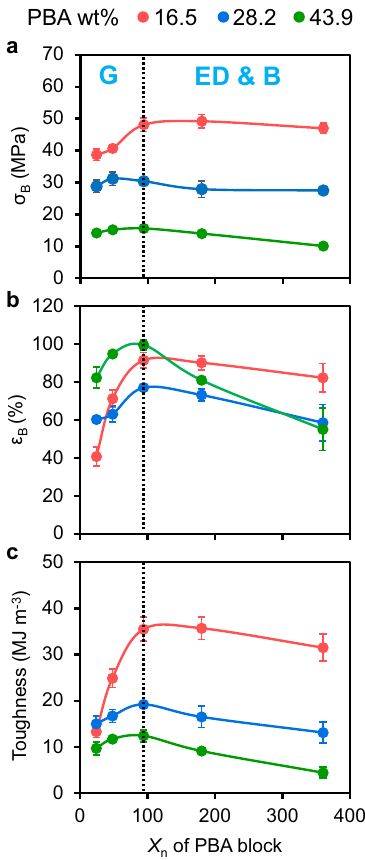
Fig. 6 Bulk mechanical (tensile) properties of samples 3D printed with varying PBA-CTA X n and PBA-CTA wt%. a Tensile stress at break ( σ B ); b Elongation at break ( ε B ); c Toughness. Materials were 3D printed using a molar ratio of [AA]/[PEGDA] = 4/1 at a fi xed PBA-CTA wt% of (16.5, red lines, 28.2, blue lines, or 43.9 wt%, green lines). G - globular morphology, ED - elongated domains, B - bicontinuous morphology. Dashed line represents the boundary between globular (G) and interpenetrating morphologies (ED and B). Error bars indicate standard deviation in at least triplicate measurements. Some error bars fall within the size of the